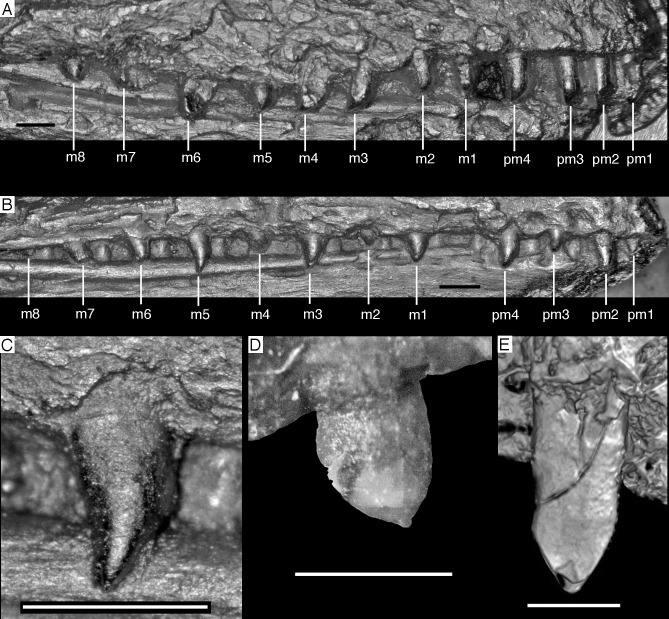
Dentition of Archaeopteryx.(A) Premaxillary and maxillary dentition of the Berlin specimen (based on a high-resolution cast held at the BSPG). (B) Premaxillary and maxillary dentition of the Eichstätt specimen (based on a high-resolution cast held at the BSPG). (C) Fifth maxillary tooth of the Eichstätt specimen (based on a high-resolution cast held at the BSPG). (D) Sixth maxillary tooth of the Solnhofen specimen. (E) Sixth maxillary tooth of the Daiting specimen in lingual view (based on synchotron data; courtesy Paul Tafforeau). m, maxillary tooth positions; pm, premaxillary teeth or tooth positions. Scale bars are 1 mm.